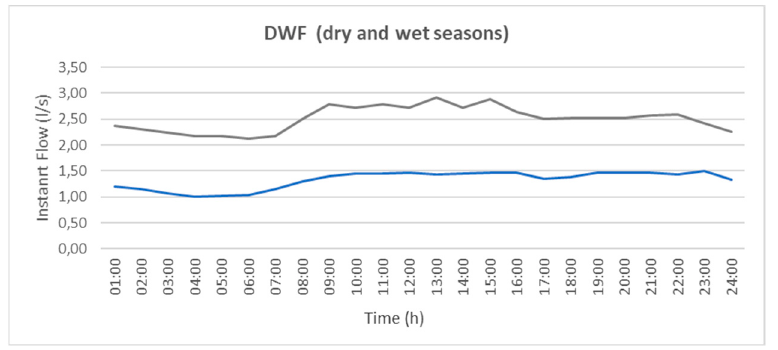
Figure 5. Average hourly flows corresponding to periods without rain (DWF) representative of the dry and wet seasons.